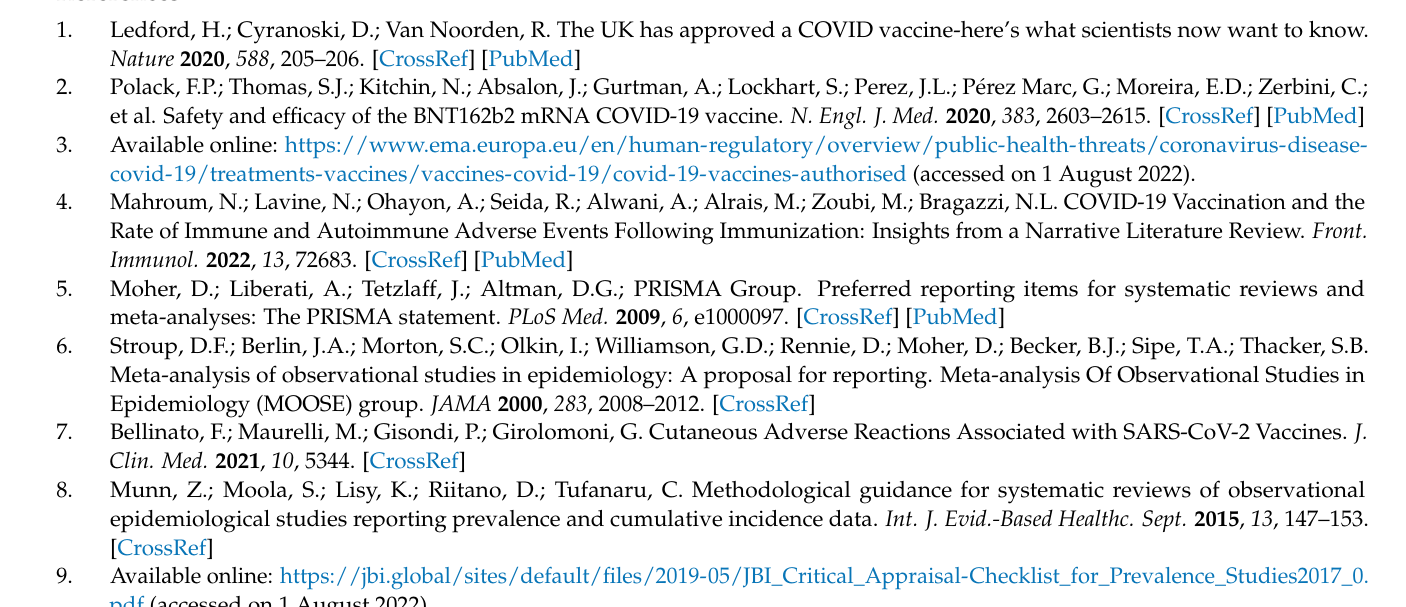
Supplementary Figure S3. Forest plot and pooled estimates of the incidence of cutaneous adverse reaction to SARS-CoV-2 vaccines in 22 eligible studies stratified by vaccine platform. Supplementary Figure S4. Forest plot and pooled estimates of the incidence of cutaneous adverse reaction to SARS- CoV-2 vaccines in 22 eligible studies stratified by study population. Supplementary Figure S5. Forest plot and pooled estimates of the incidence cutaneous adverse reaction to SARS-CoV-2 vaccine in 22 eligible studies stratified by study country. Supplementary Figure S6. Funnel plot for eligible studies assessing the incidence of cutaneous adverse reaction to SARS-CoV-2 vaccine in 22 eligible studies. Egger test p < 0.001. Supplementary Table S1. Search Queries. Supplementary Table S2. Characteristics of excluded studies. Supplementary Table S3. outcome measures of included